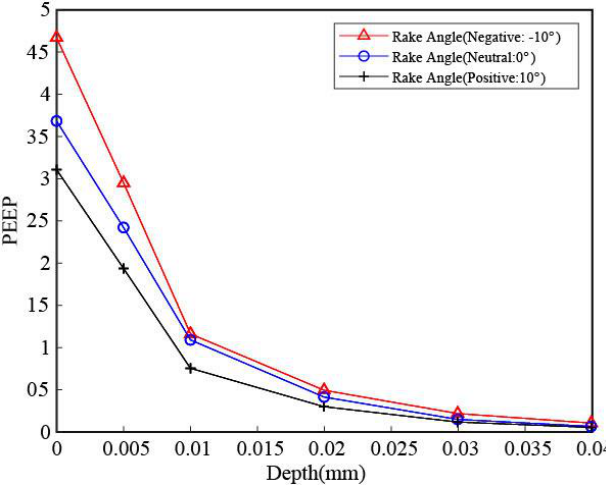
Figure 11. Simulated subsurface deformation of workpiece machined with different rake angle tools.